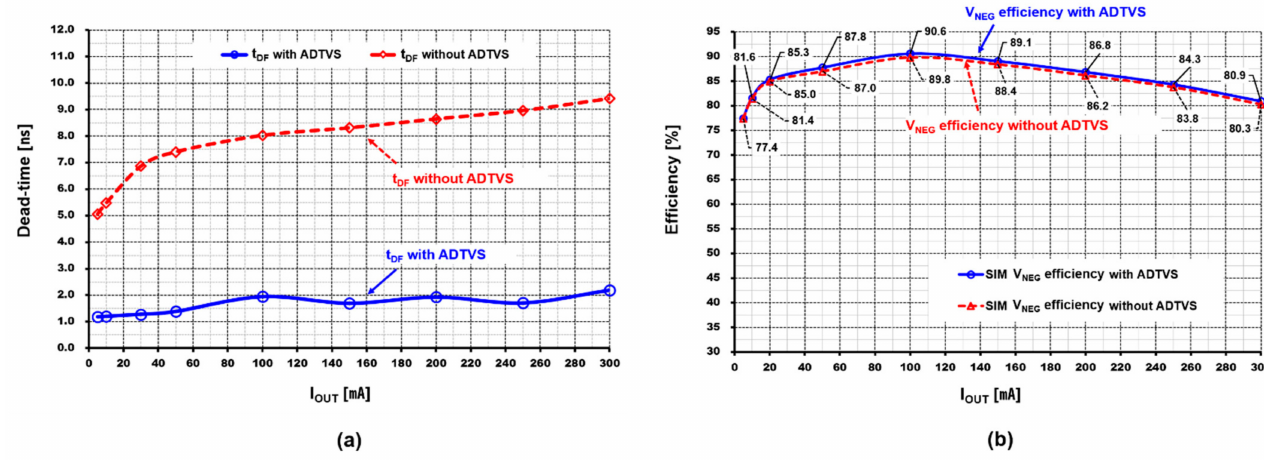
Figure 10. Simulation results of V NEG using the ADTVS circuit: ( a ) dead-time; ( b ) power